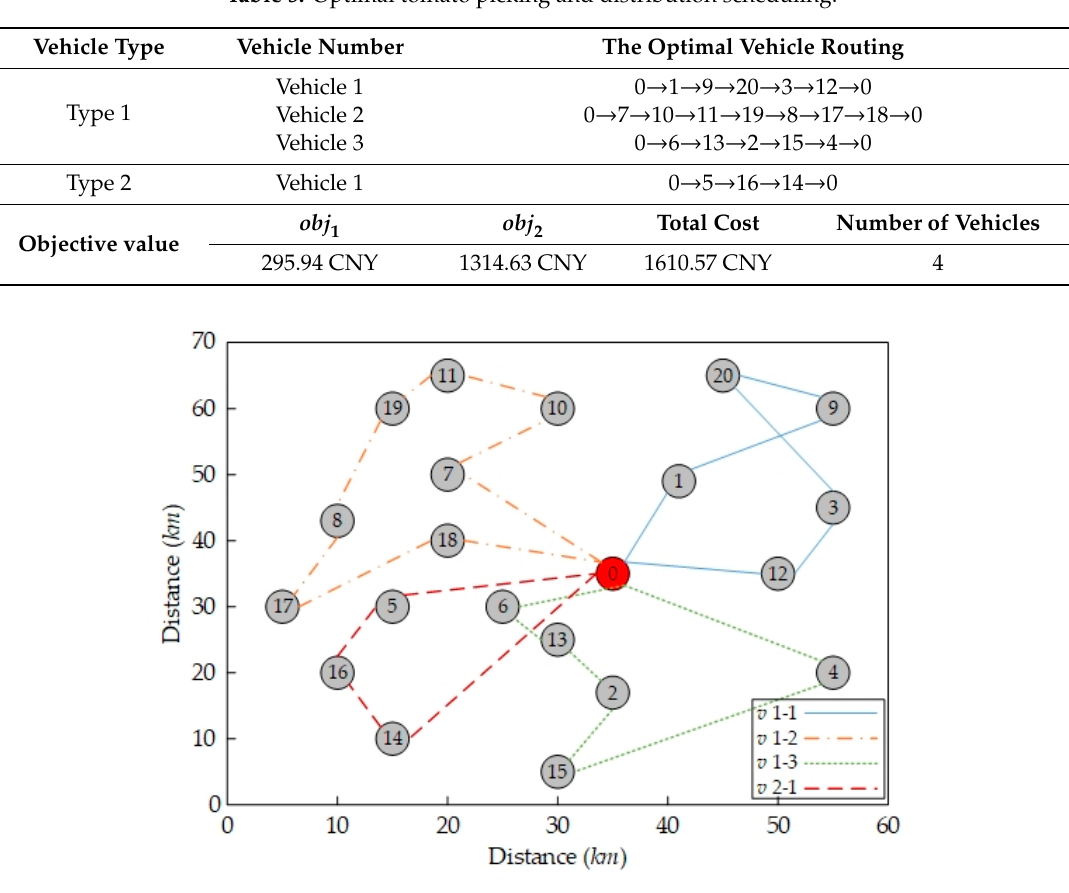
Figure 6. Schematic diagrams of the optimal vehicle routing.